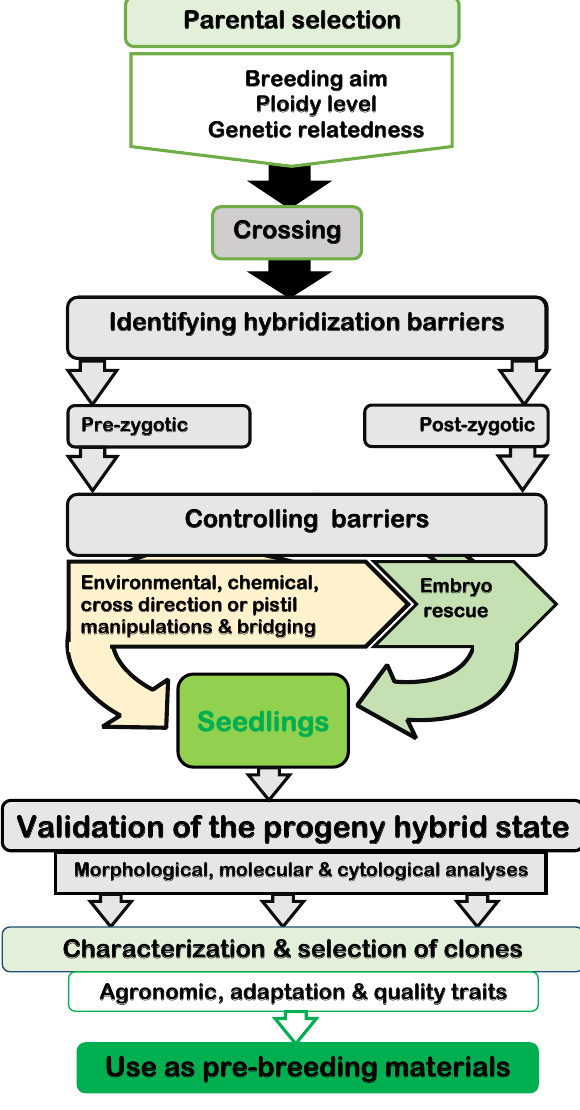
Figure 8. Scheme for creating a viable interspecific breeding program for